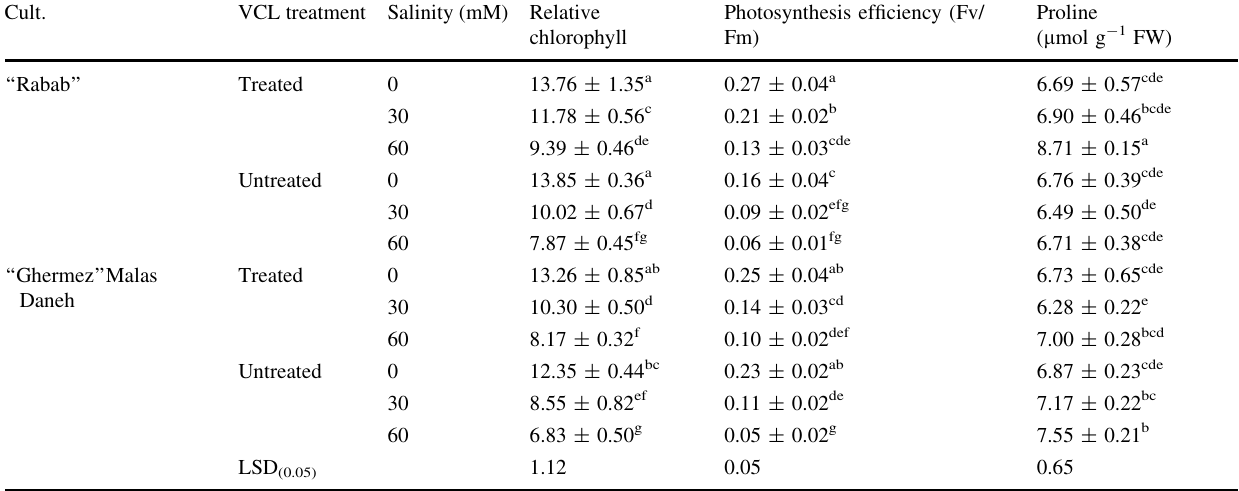
Table 3 Effects of VCL treatments on chlorophyll, photosynthesis efficiency, and proline of pomegranate seedlings under NaCl-induced salt stress